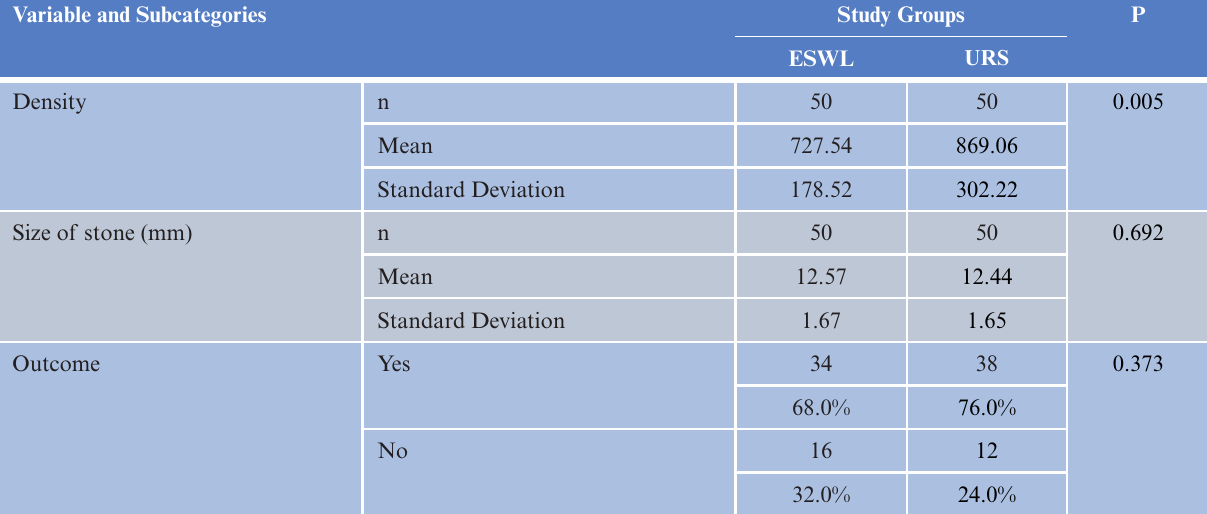
Table 3: Comparison of density, size of stone (mm), and outcome between study